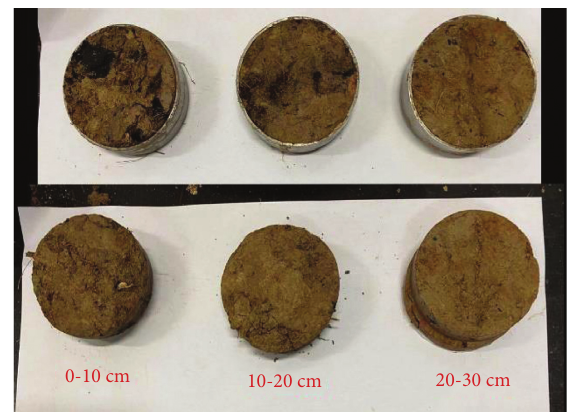
Figure 3: Root–soil composite sample after the direct shear test.